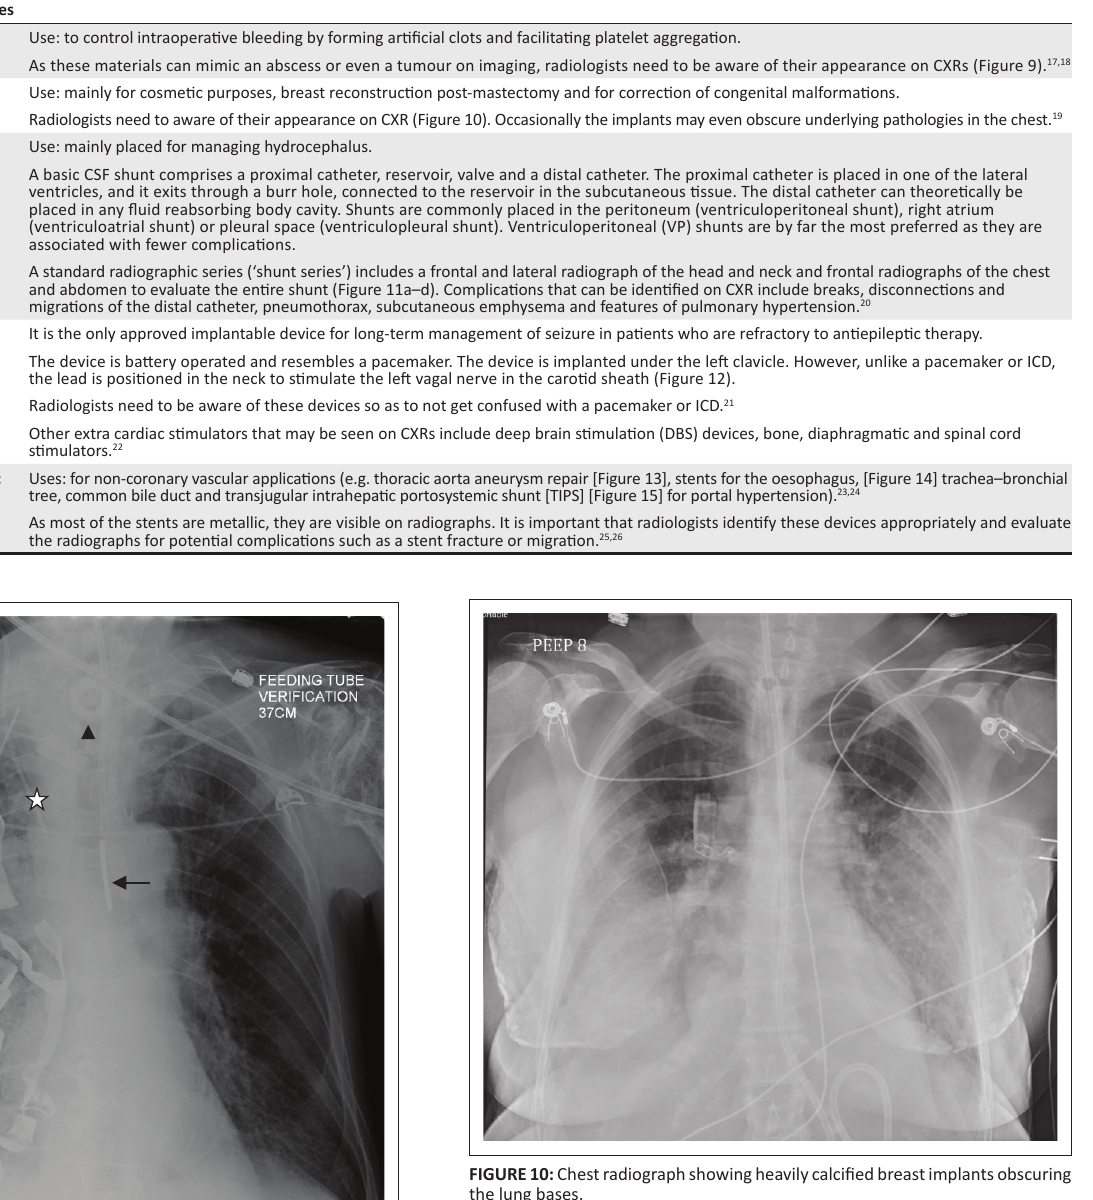
TABLE 2: A list of some of the other non-cardiac iatrogenic materials and medical devices that may be seen on chest radiographs. Non-cardiac iatrogenic Their uses and how to assess them materials and medical devices Haemostatic agents